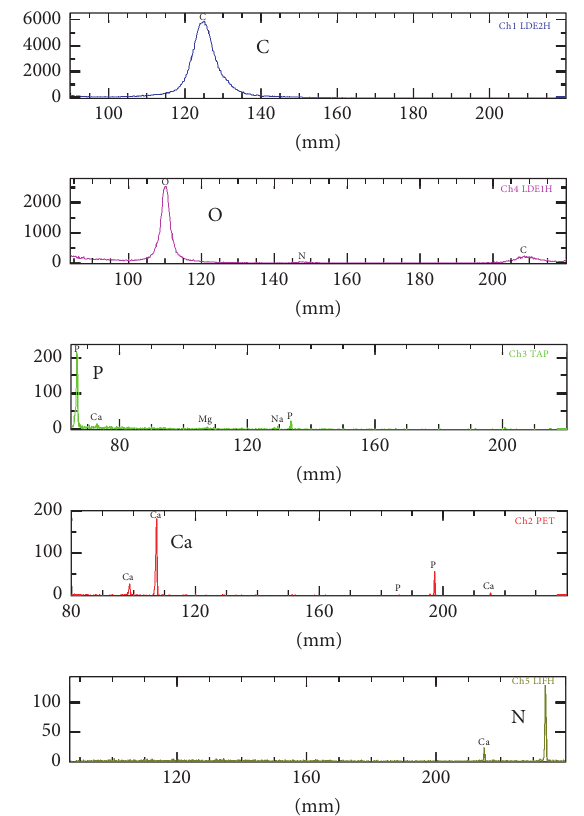
Figure 10: Analysis of bone composition. Cellular compositions were similar to those observed in normal bone